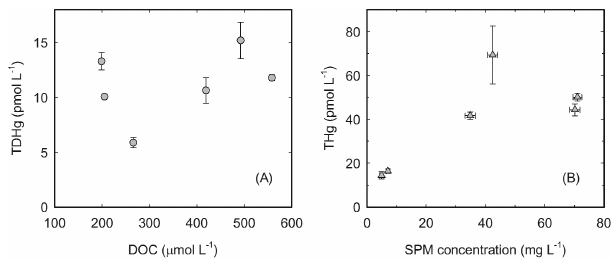
Figure 9. (a) Total dissolved mercury and DOC concentrations across the early freshet in 2013 were weakly correlated ( r 2 = 0.15). (b) Total Hg concentration (unfiltered) is positively correlated with SPM concentration ( r 2 =